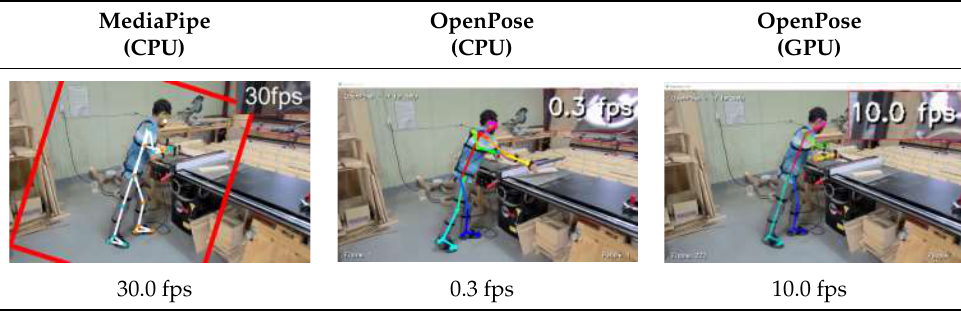
Table 3. The FPS comparison of the posture of a wood manufacturing worker.